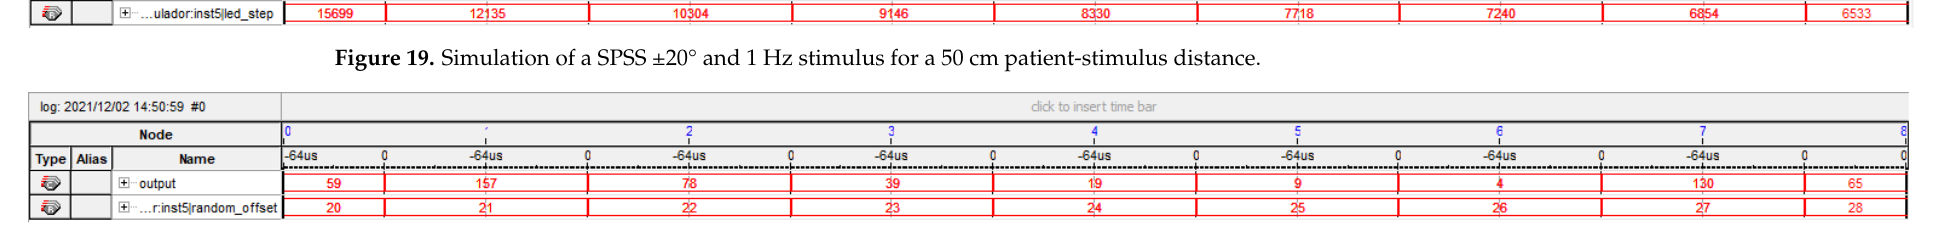
Figure 20. Simulation of a RSAC ±30° and 1.2 Hz stimulus for a 100 cm patient-stimulus